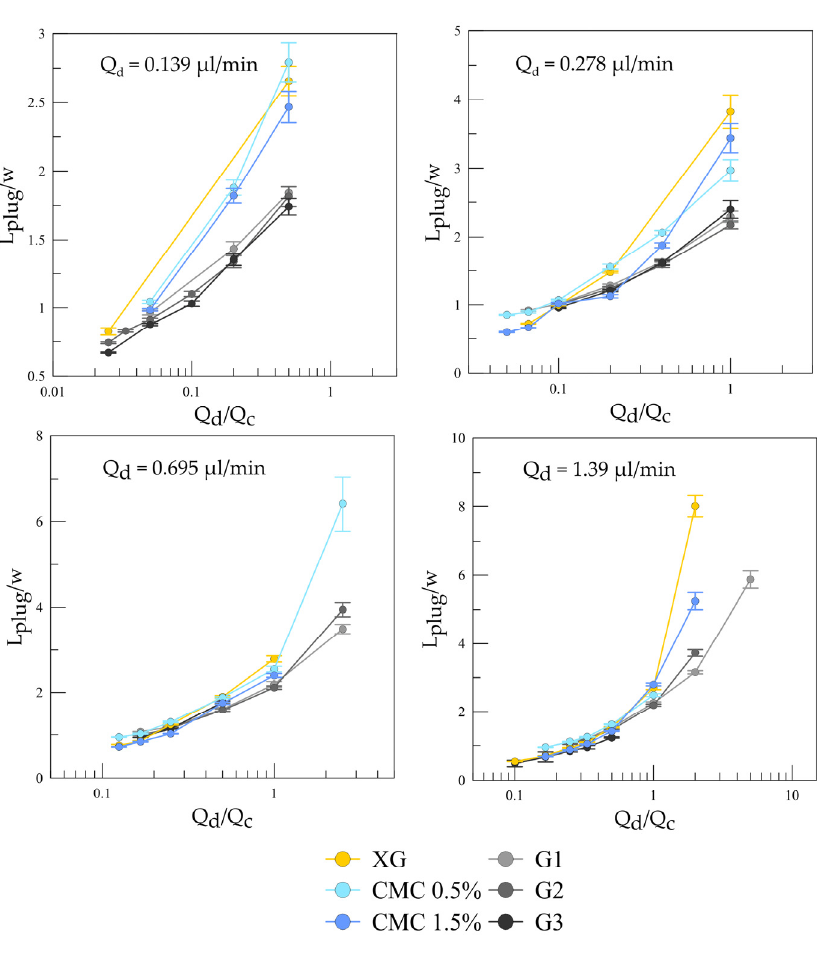
Figure 8 . Slug length depending on flow-rate ratio at different dispersed-phase flow rates for the Newtonian and non-Newtonian dispersed phases.